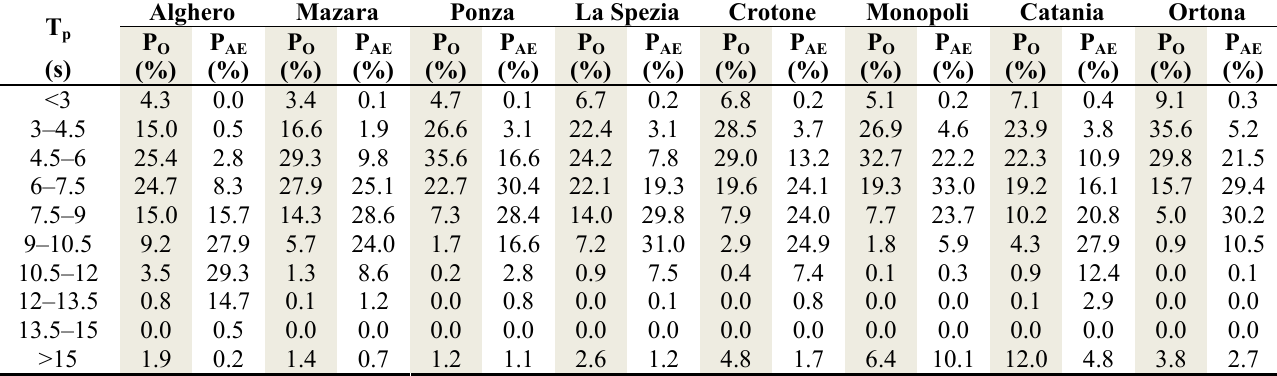
Table 3. Percentage of occurrence (P (P on white columns) corresponding to different intervals of wave peak AE